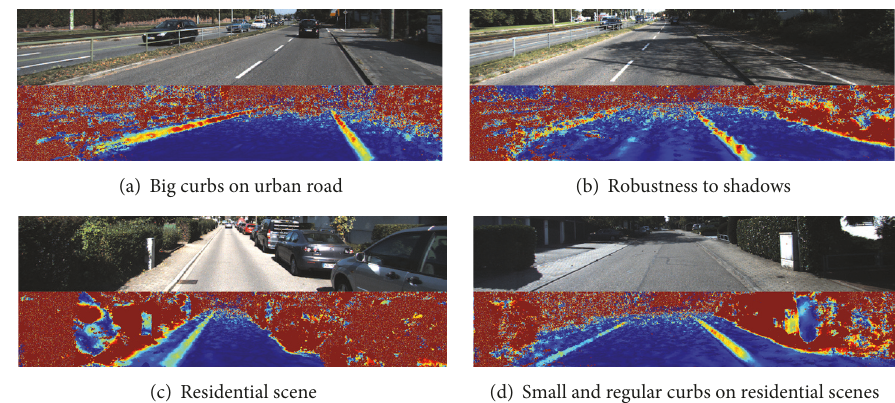
Figure 6: Curvature values on different urban scenes.